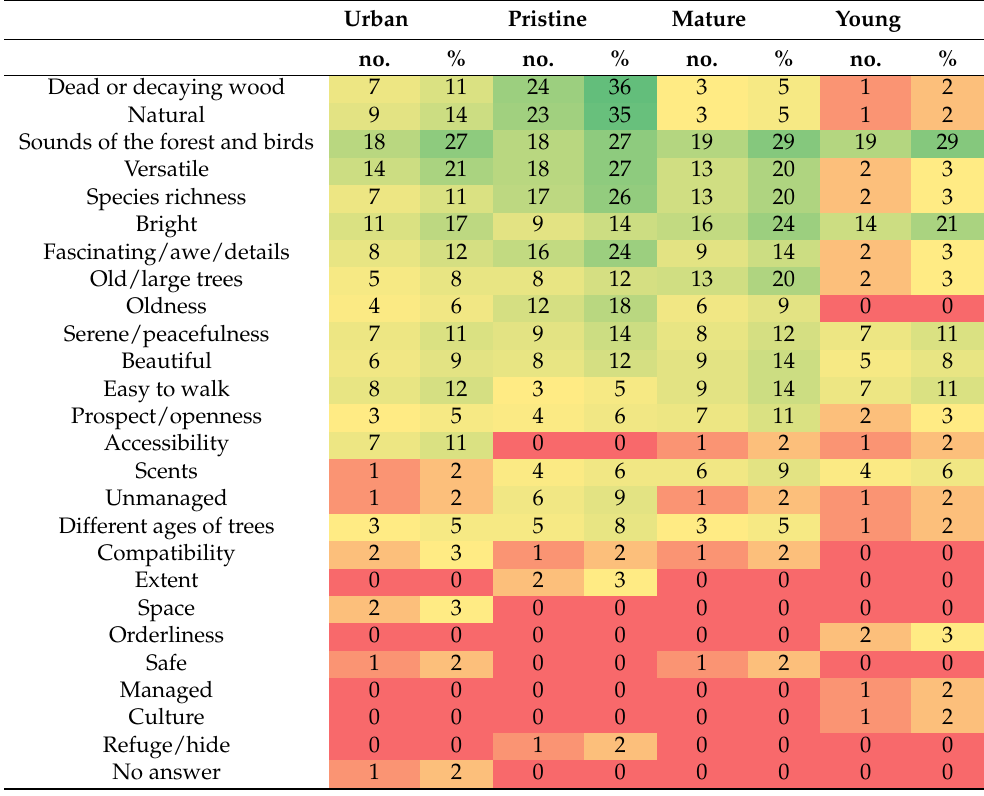
Table 4. The number and proportion of characteristics mentioned that people liked in the forests. The stronger green, the more liked responses, and the stronger red, the less liked